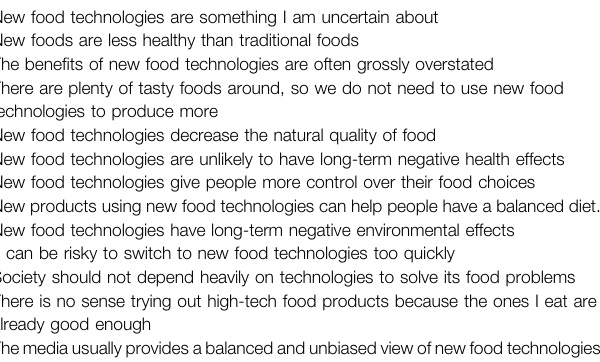
TABLE 1 | Food technology neophobia questions